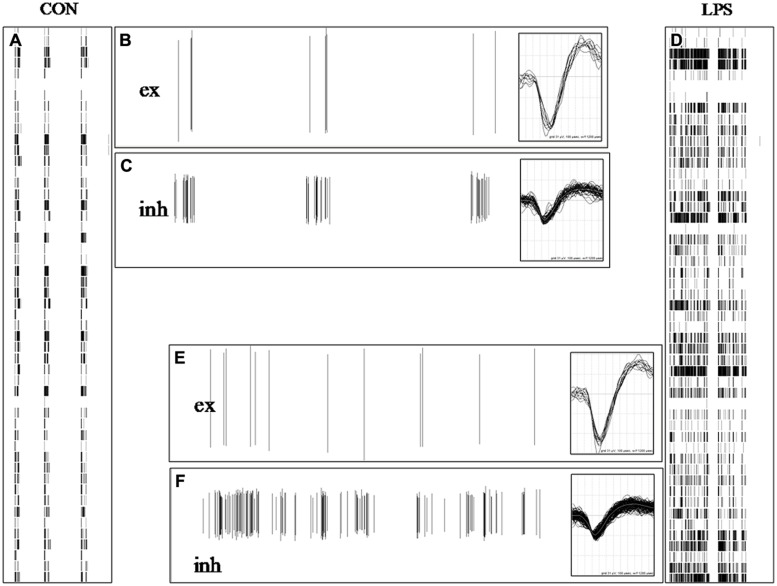
Lipopolysaccharide did not affect action potential waveform neither in excitatory nor in inhibitory neurons. (A,D) 35 s-long windows in which are shown raster plots of timestamps of normal and atypical burst in control (CON) and 6 h after adding LPS (each point in a column contains data from one electrode). In (A) are present three brief bursts and in (B) one long burst in LPS (identified as one single up-state because the short; <3 s) inter-spike interval was well below the average IBI value of ∼15 s. (B,C,E,F) 35 s-long windows showing plots of spike amplitude (vertical lines) vs. time in control and during LPS for identified excitatory (B,E) and inhibitory (C,F) neurons in two different electrodes. The number of identified excitatory and inhibitory cells was 69 and 24, respectively. The insets associated with (B,C,E,F) show the superimposed spikes recorded in the respective windows and their vertical and horizontal dimensions correspond to +62/-93 μV and 1.2 ms, respectively.